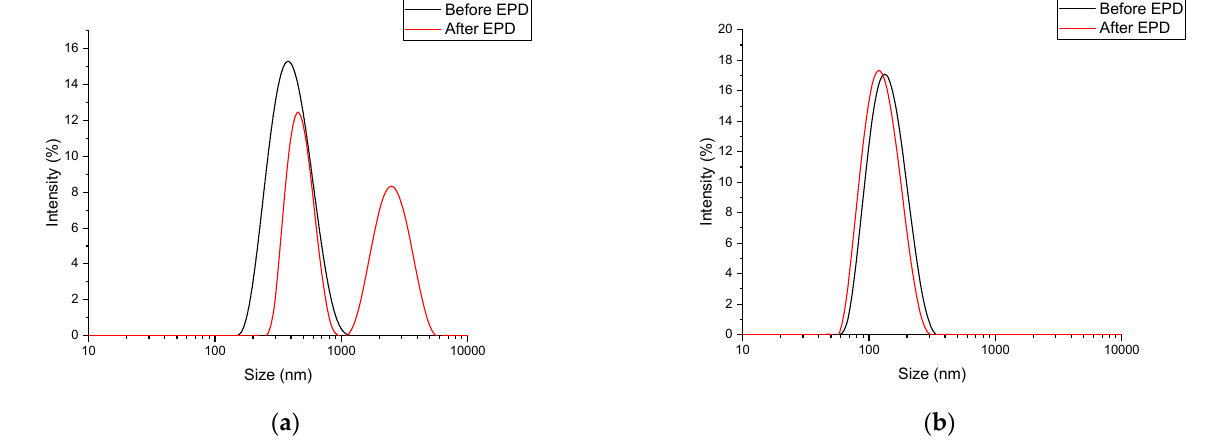
Figure 2. Size distribution by volume in ( a ) YLO_i_1 and ( b ) YLO_iA_1 suspensions before and after EPD.